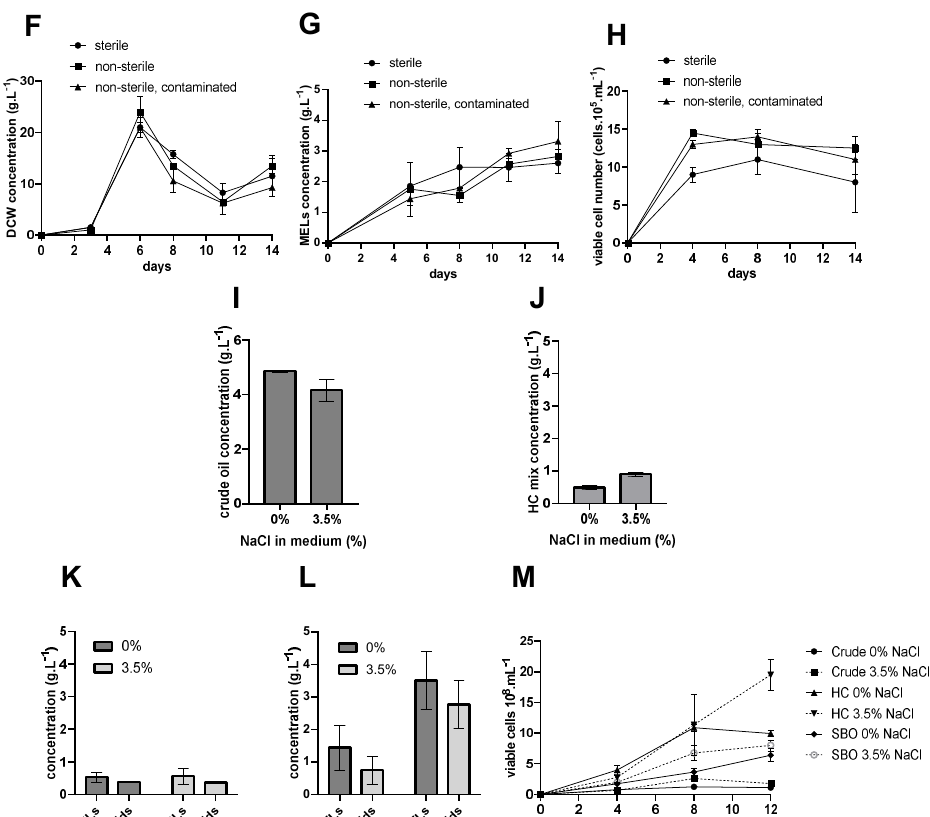
Figure 1. ( A )—Values of relevant parameters in flasks containing various concentrations of NaCl